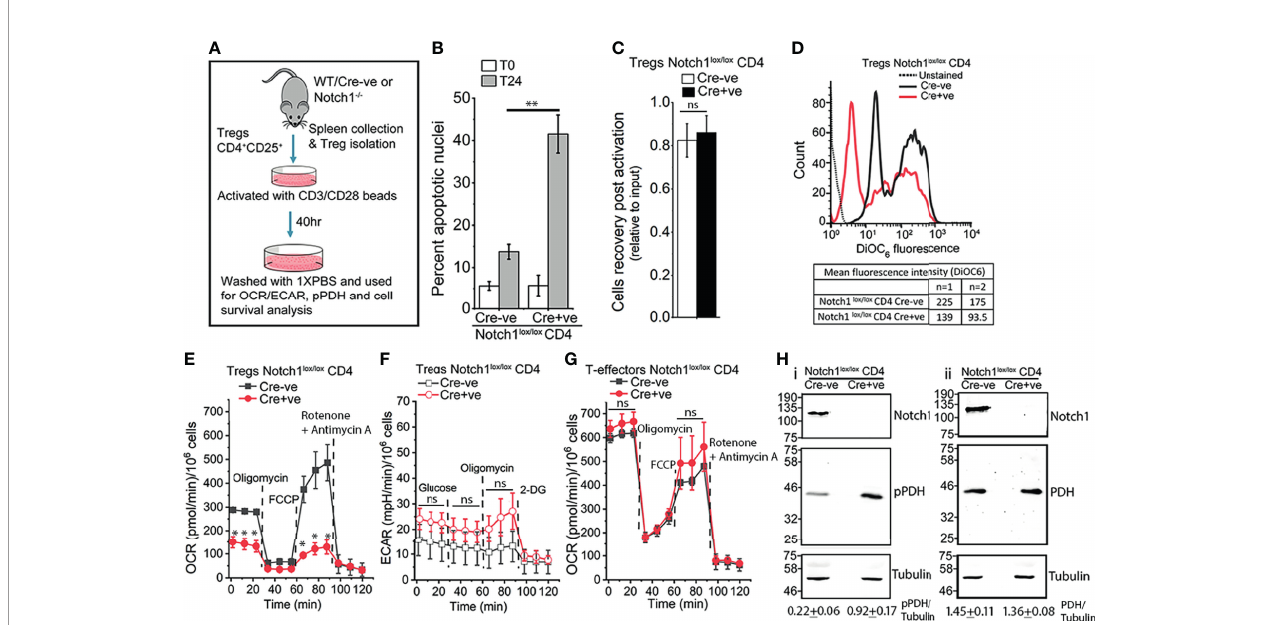
FIGURE 1 | Notch1 signaling regulates mitochondrial metabolism in Tregs. (A) Experimental protocol for Tregs activation. (B) Percent apoptotic nuclei in activated Notch1 +/+ (Cre-ve; Notch1 lox/lox ) and Notch1 -/- (Cre+ve; Cd4-Cre::Notch1 lox/lox ) Tregs at onset (T0), and after 24 h culture (T24) in medium without IL-2. (C) Cell recoveries in the two genotypes at the end of the 40 h activation protocol. (D) Representative histogram overlay and mean fl uorescent intensity (MFI) of DioC 6 in freshly activated Notch1 +/+ (black) and Notch1 -/- (red) Tregs. The dotted line indicates unstained Tregs. (E) Oxygen consumption rate (OCR) in activated Notch1 +/+ ( ▪ ) and Notch1 -/- ( (cid:129) ) Tregs at baseline and following sequential addition of 1.25 m M Oligomycin, 1 m M FCCP and 1 m M Rotenone + 1 m M Antimycin A. (F) Extracellular acidi fi cation rate (ECAR) in activated Notch1 +/+ ( ▫ ) and Notch1 -/- ( ⚬ ) Tregs at baseline and in response to sequential treatment with 10 mM glucose, 1.25 m M oligomycin and 50 mM 2-deoxyglucose. (G) OCR measured in CD4 + naïve T-cells isolated from Notch1 +/+ ( ▪ ) or Notch1 -/- ( (cid:129) ) mice and activated as shown in A, in response to 1.25 m M Oligomycin, 1 m M FCCP and 1 m M Rotenone + 1 m M Antimycin A. (H) Representative immunoblots of whole cell lysates from activated Notch1 +/+ and Notch1 -/- Tregs. Lysates were divided into two and analyzed in parallel. Membranes were probed either for pPDH, Notch1, and Tubulin (H – I) or PDH, Notch1, and Tubulin (H-ii) . The immunoblots are representative of three independent experiments. The densitometry analysis (Mean ± SD from three independent experiments) of pPDH and PDH relative to Tubulin are shown below the immunoblots. The same pool of activated Tregs was tested in (E, F) . In (E – G) , plots shown as mean ± SD of readings in triplicate wells and are representative of two separate experiments. * and ** denote signi fi cant differences with p-value ≤ 0.05 and ≤ 0.01 respectively, ns: not signi fi cant, examined using the unpaired student ’ s